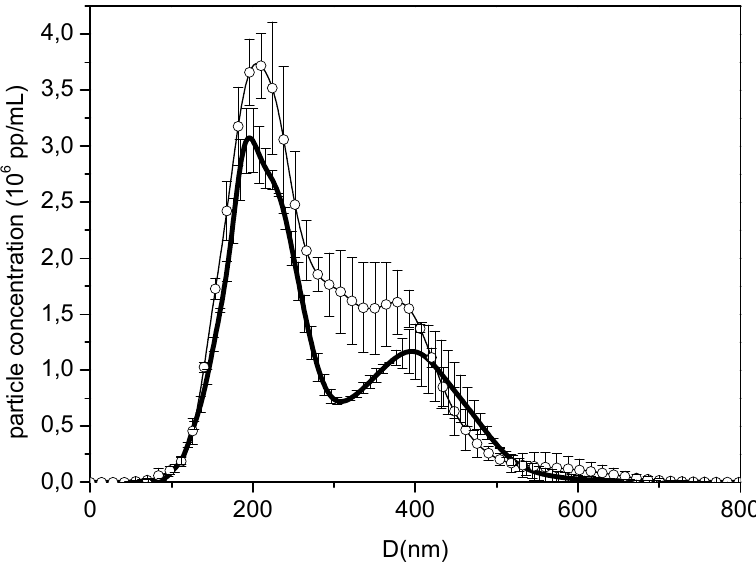
Figure 3. Hydrodynamic diameter distribution of NP (circles) and NP-BMP2 (thick black line) measured at pH 7.0 (phosphate buffer) by nanoparticle tracking analysis (NTA).